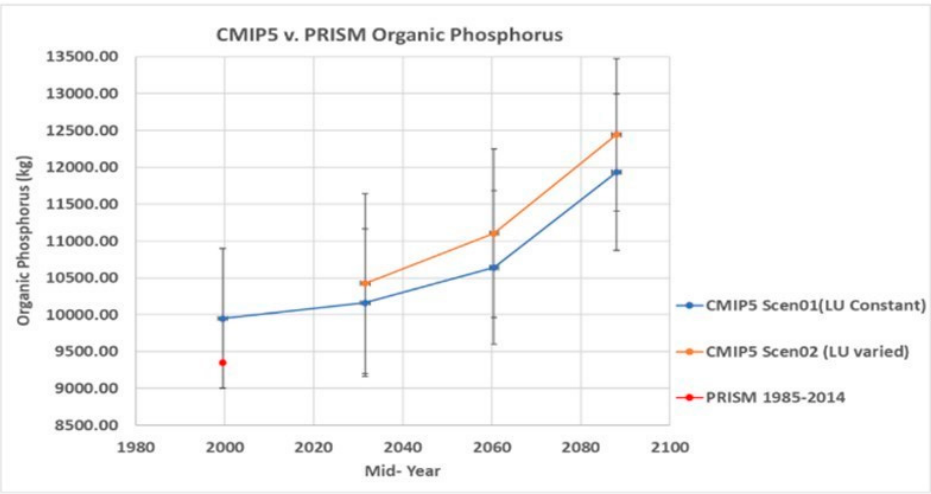
Figure 7. PRISM vs. average of 20 CMIP5 GCMs organic phosphorus (2018–2100).